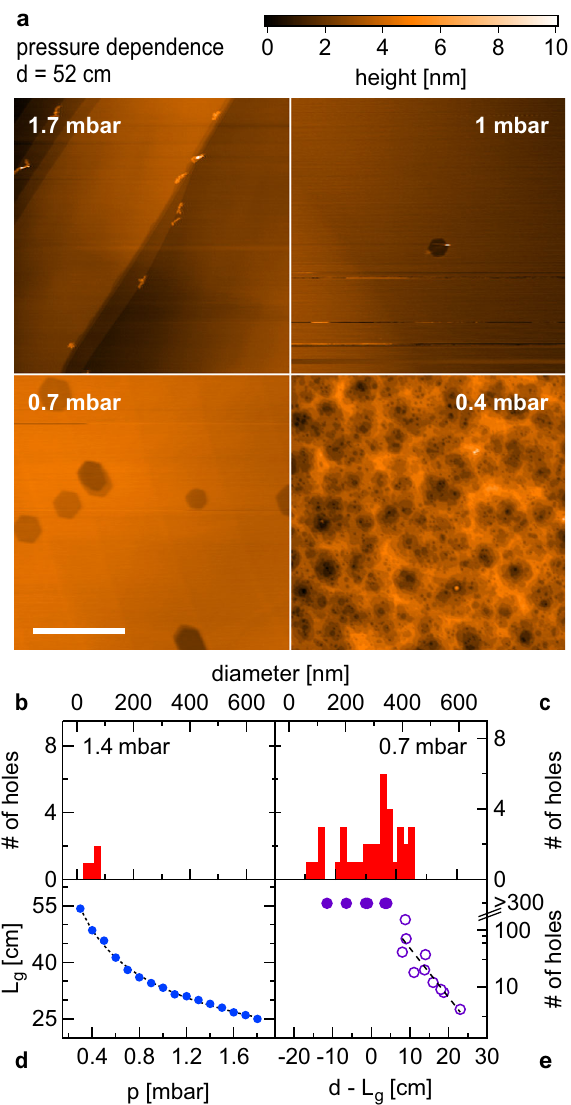
Fig. 2 Pressure dependence of graphite exposures. a AFM images (tapping mode) of graphite surfaces for various p , as indicated, exposed for 1 h at d = 52 cm and T = 400 °C, all shown on the same color scale. All panels are 3 × 3 μ m 2 , scale bar is 1 μ m. b , c Histograms from 10 × 10 μ m 2 scans, displaying the number of holes against hole diameter (bin size 20 nm) for p as labeled. d Length L g of the optically visible plasma as a function of p . The dashed curve is a ffiffiffi p fi t. e Number of holes vs. distance from plasma edge d − L 1 = p A lower bound of 300 holes is given for the heavily etched cases where an exact hole-count was not feasible. The dashed black line is an exponential fi t to the data with < 300 holes with 1/e decay length ~ 5 cm